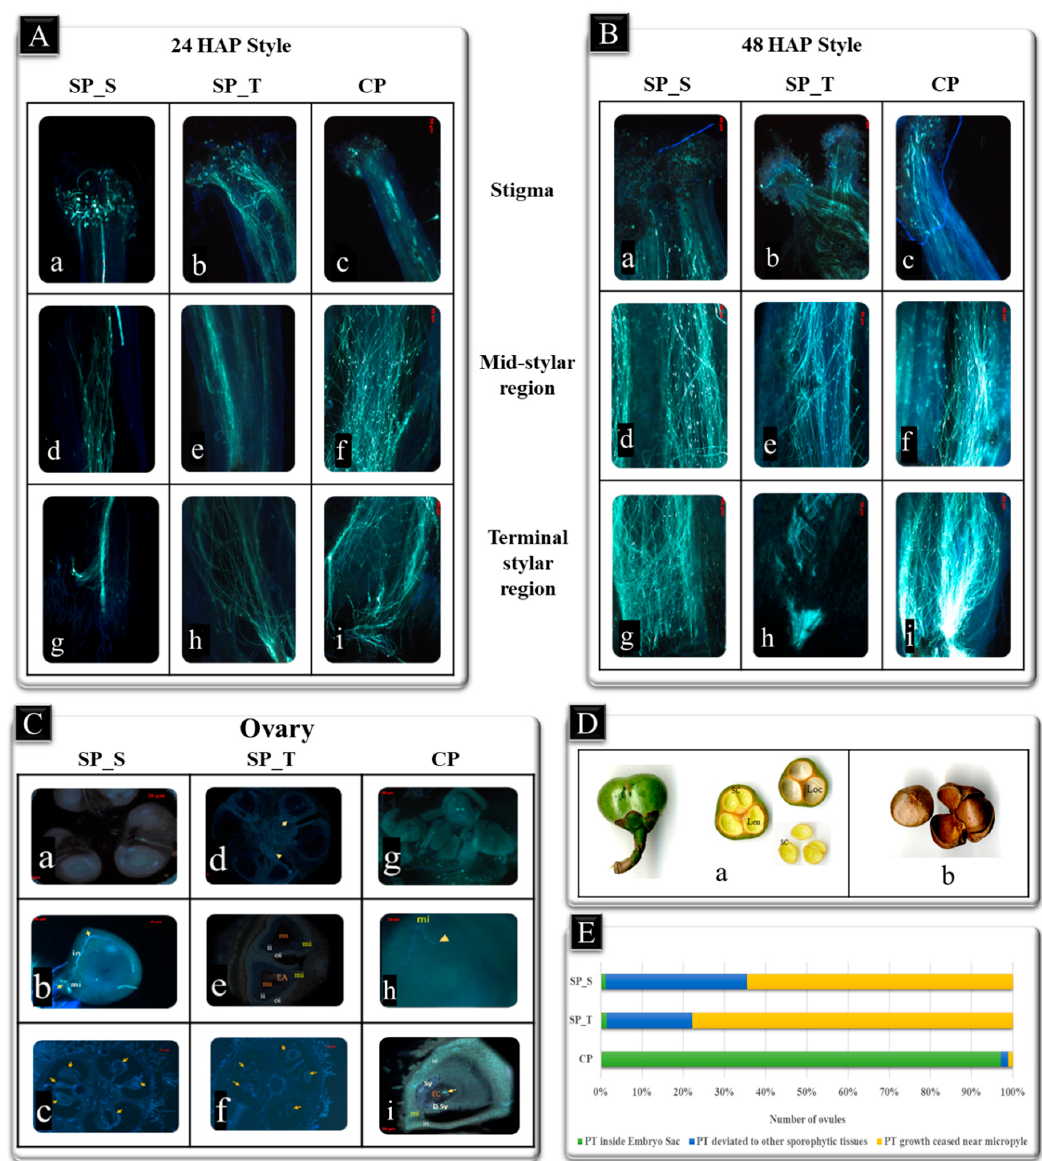
Figure 1. Pollen tube (PT) growth in self-pollinated pistil (SP) and cross-pollinated pistil (CP). (A)